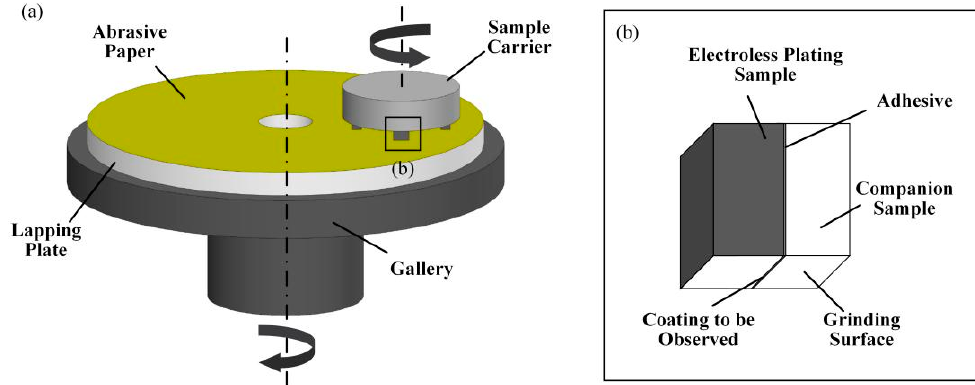
Figure 2. ( a ) Schematic diagram of grinding method; ( b ) abraded sample.